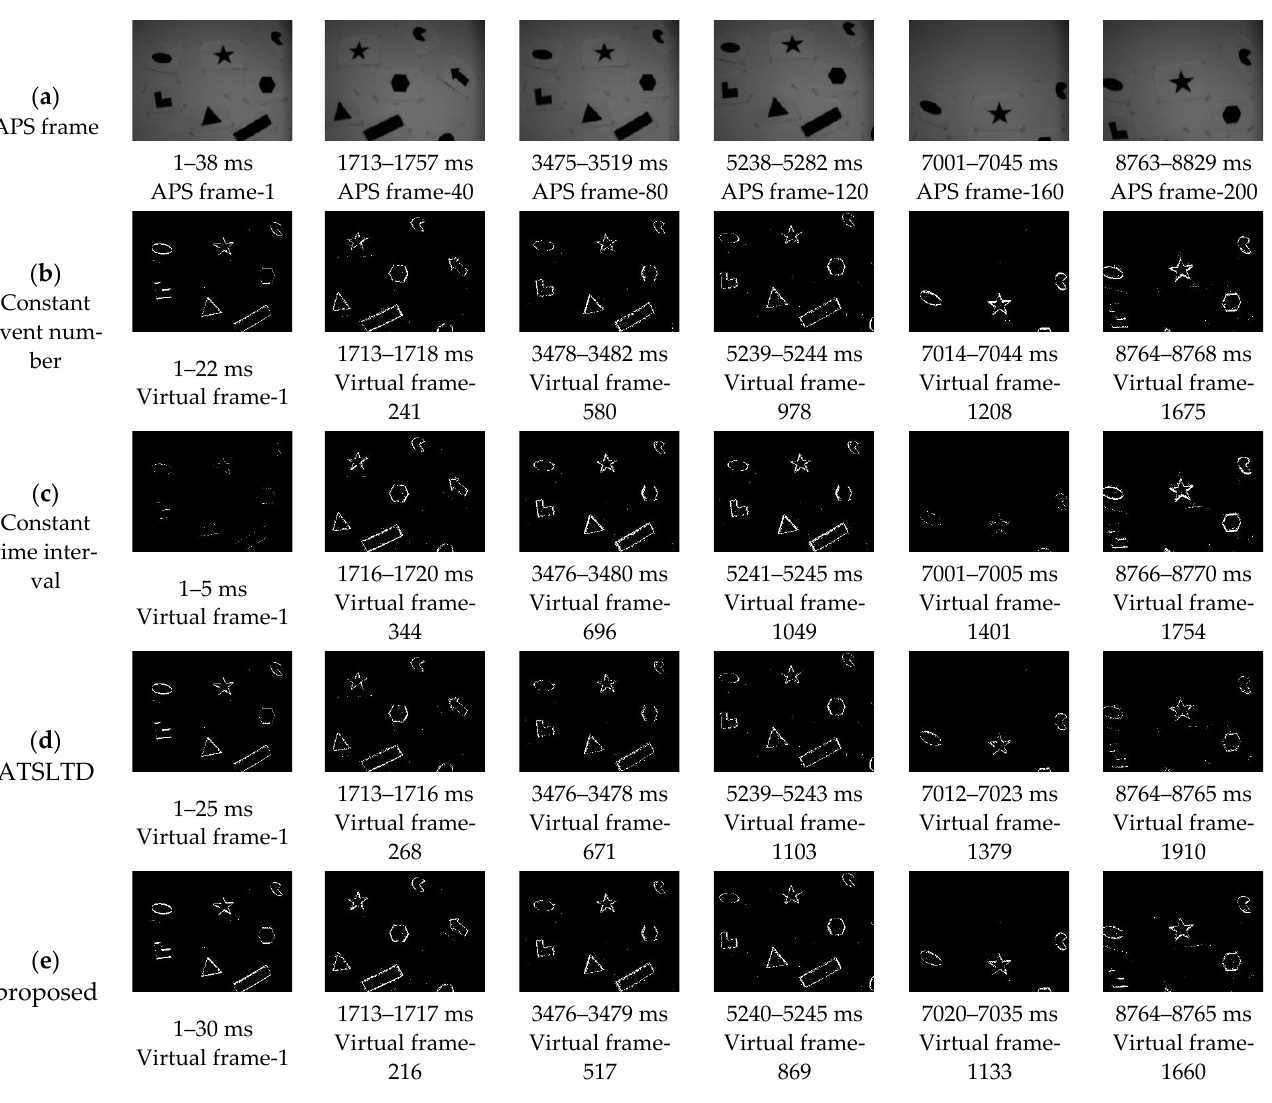
Figure 12. ( a ) APS frame; ( b ) virtual frame constructed with constant event number; ( c ) virtual frame constructed by constant time interval; ( d ) virtual frame constructed with ATSLTD; ( e ) virtual frame constructed with the proposed method.